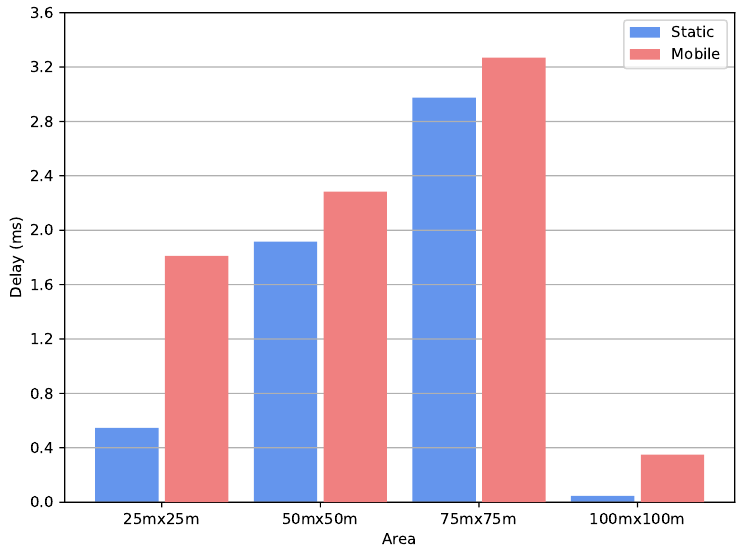
Figure 7. Data delay for trees vs. animals.